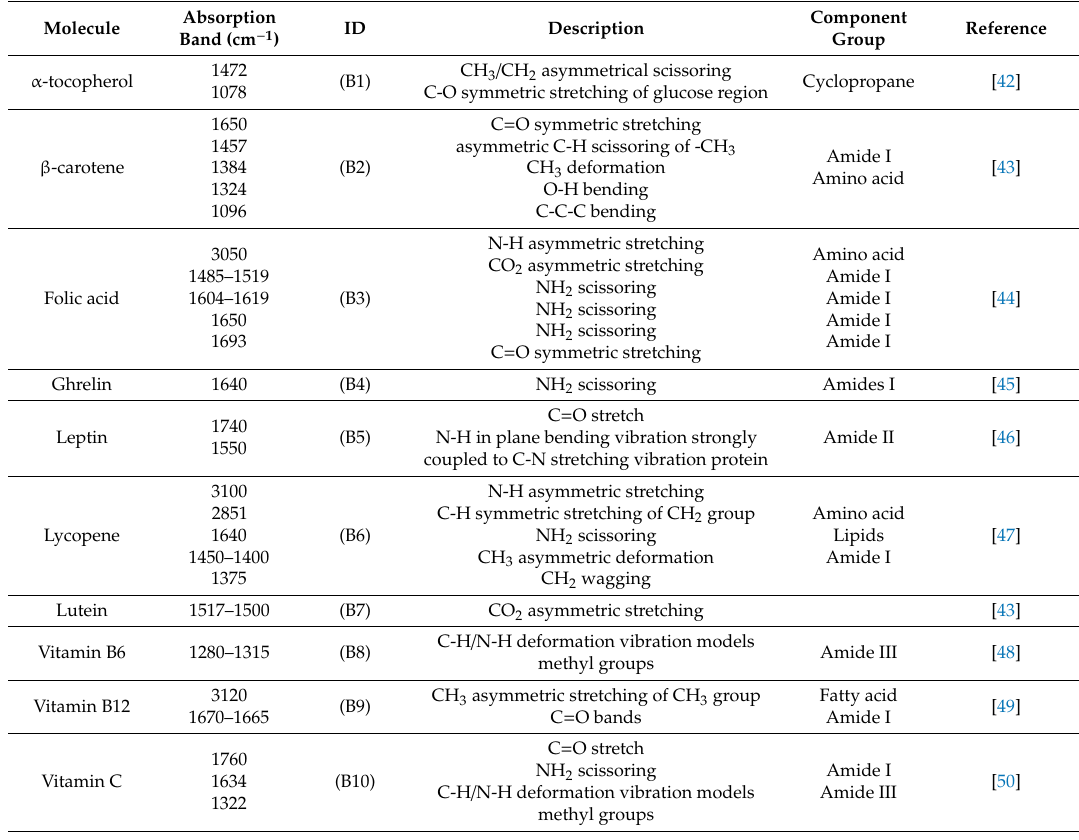
Table 1. Molecules identified in the composition IR spectra of children’s sera.